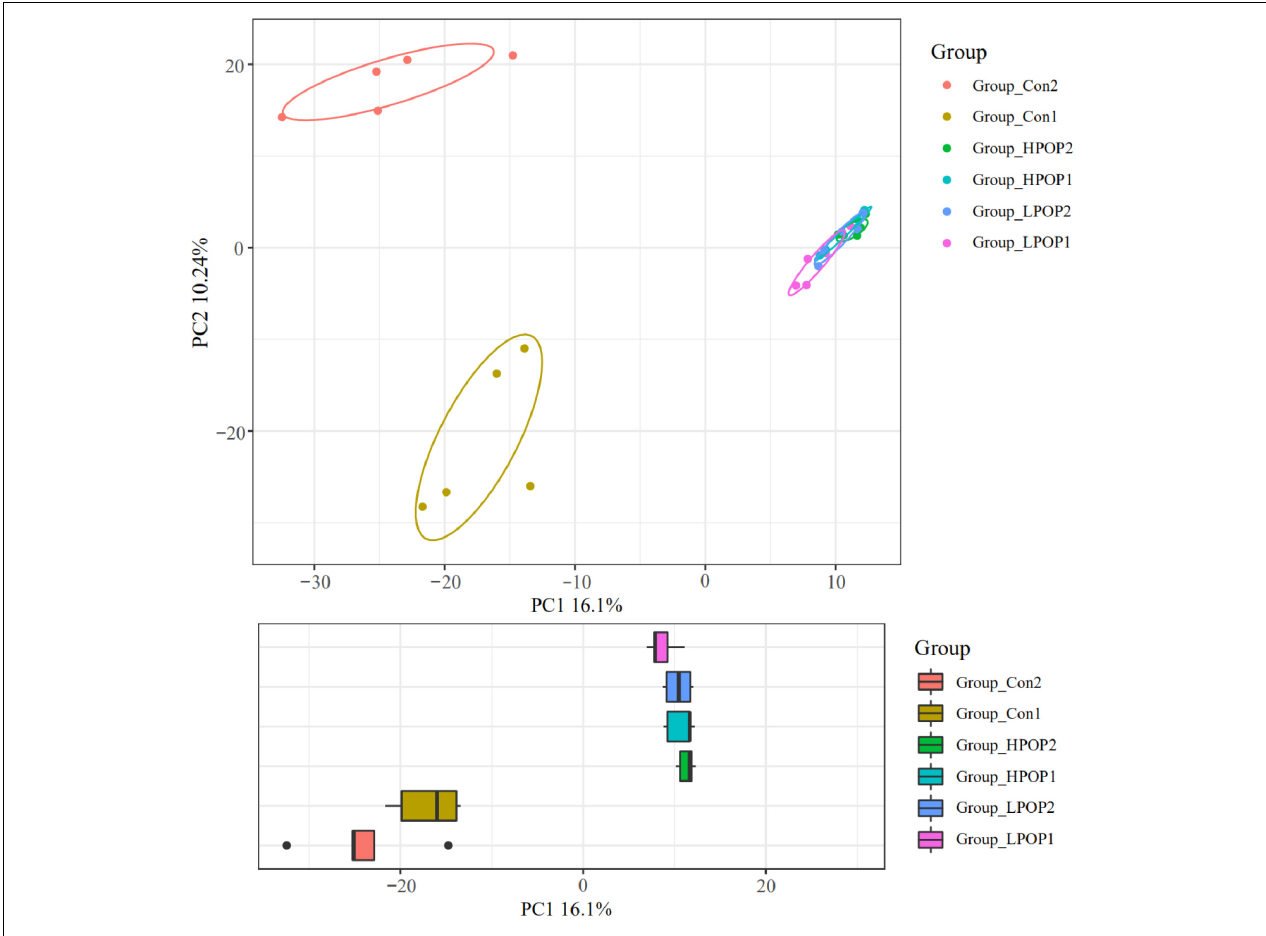
FIGURE 3 | Principal component analysis (PCA) of the microbial community composition after 24 and 48 h in vitro fecal fermentation with